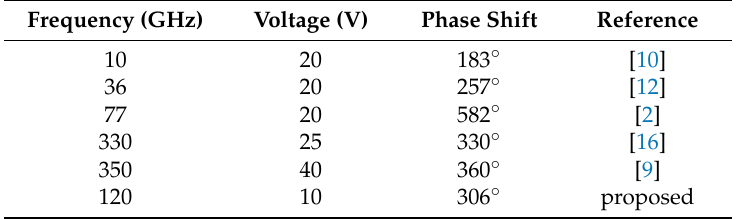
Table 1. Comparison of performances for liquid crystal (LC)-base phase shifter.